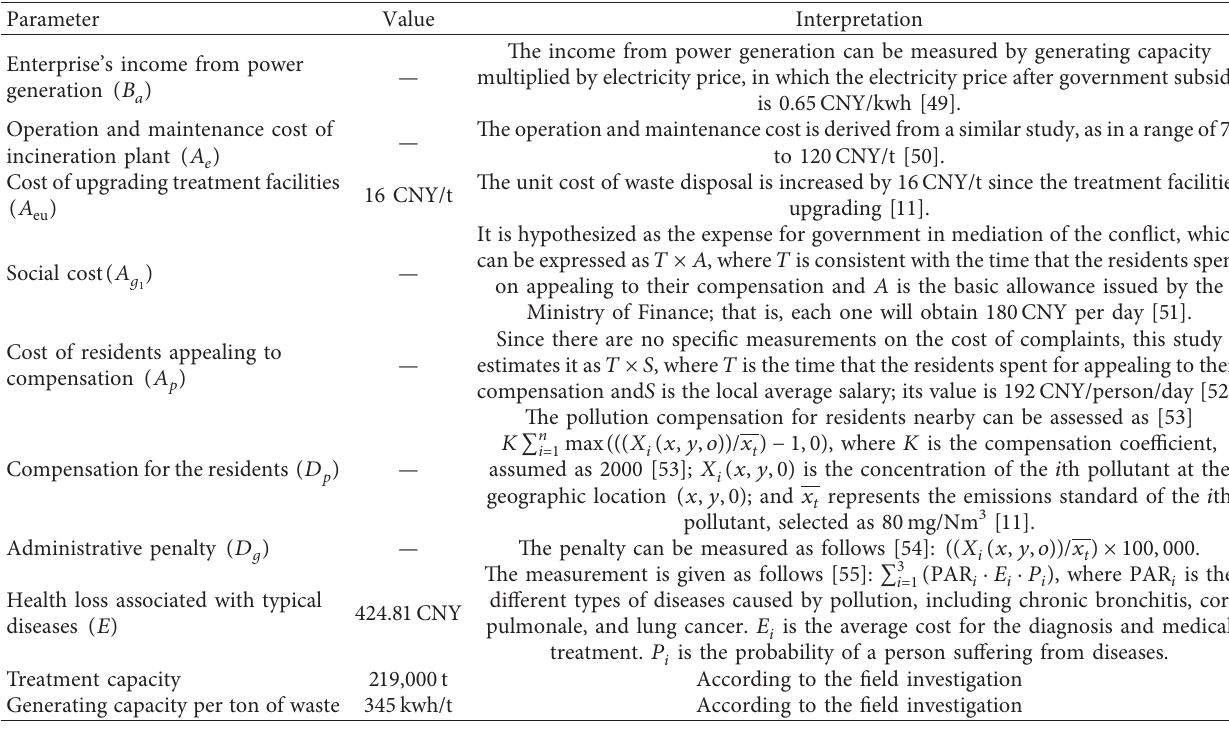
Figure 1: The three players’ evolutionary game-based SD model. (a) The enterprise. (b) The government. (c) The Table 5: Interpretation of the key influencing factors.